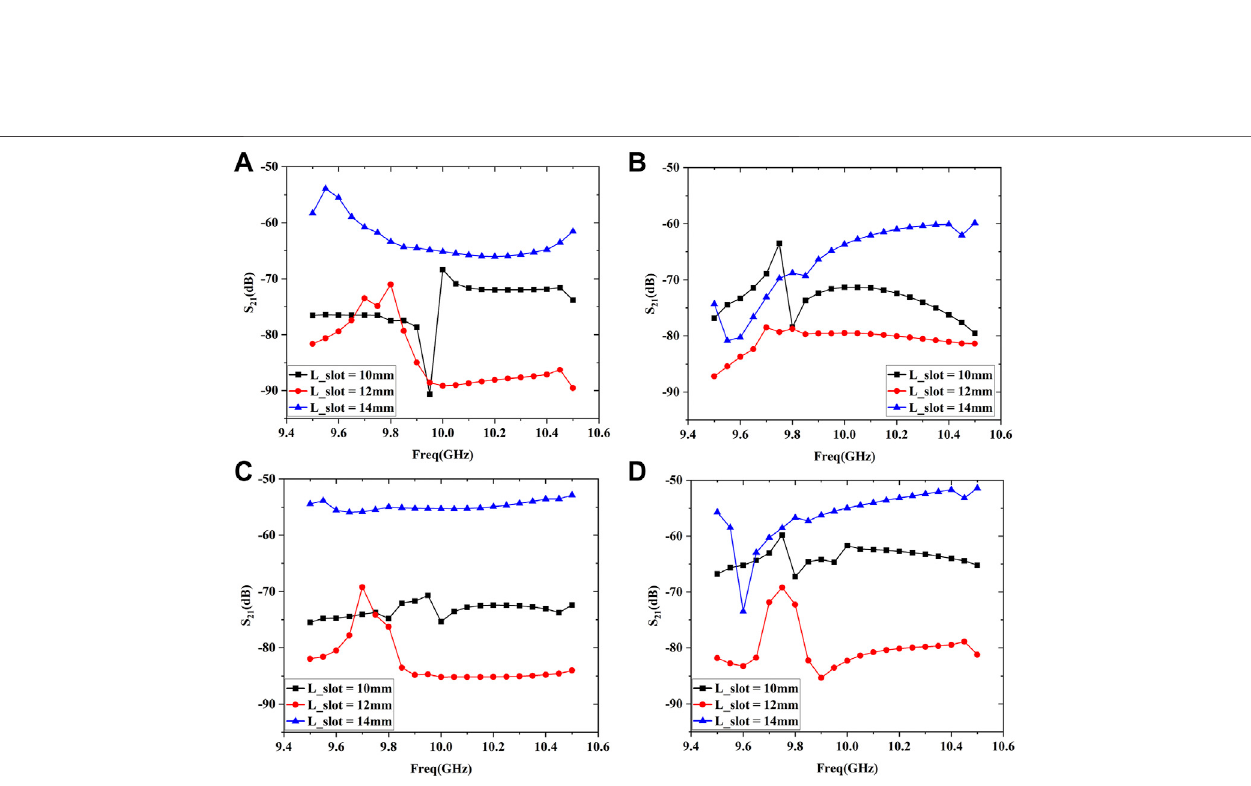
Frontiers in Physics |